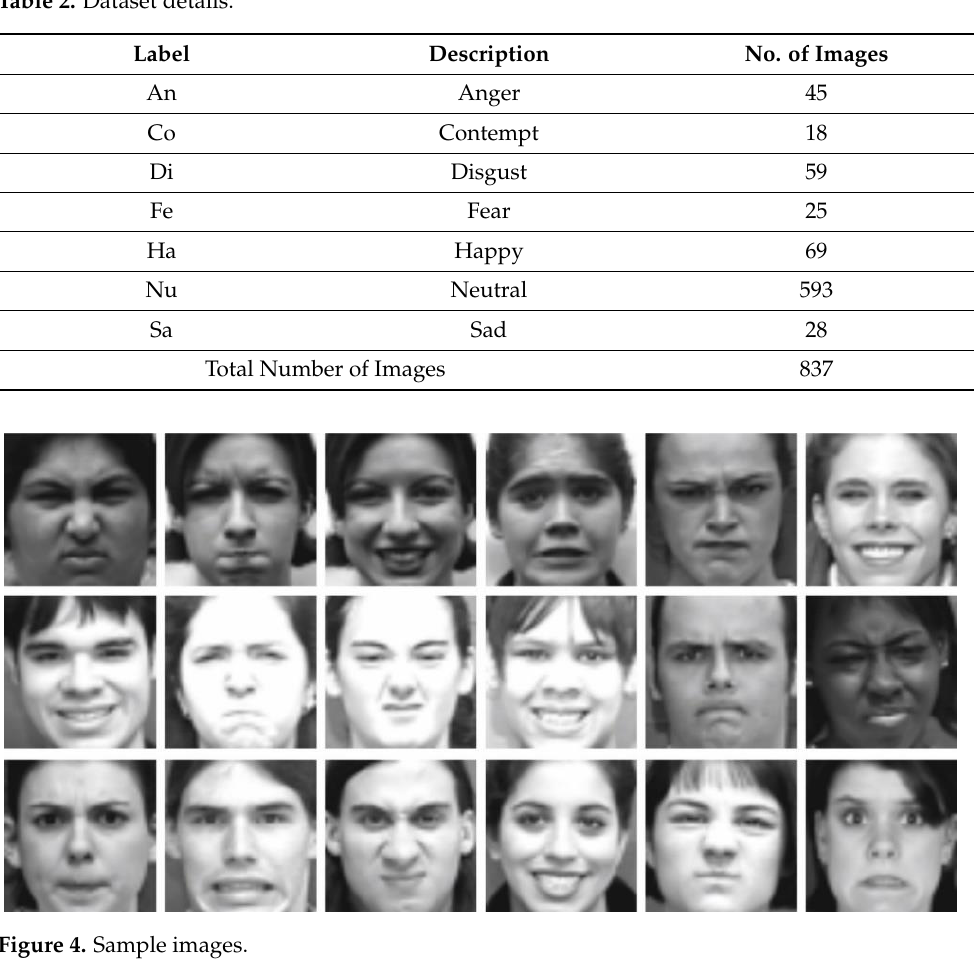
Figure 5. Confusion matrices of the RFER-EADL algorithm: ( a ) 70% of the TR dataset, ( b ) 30% of the TS dataset, ( c ) 80% of the TR dataset, and ( d ) 20% of the TS dataset.